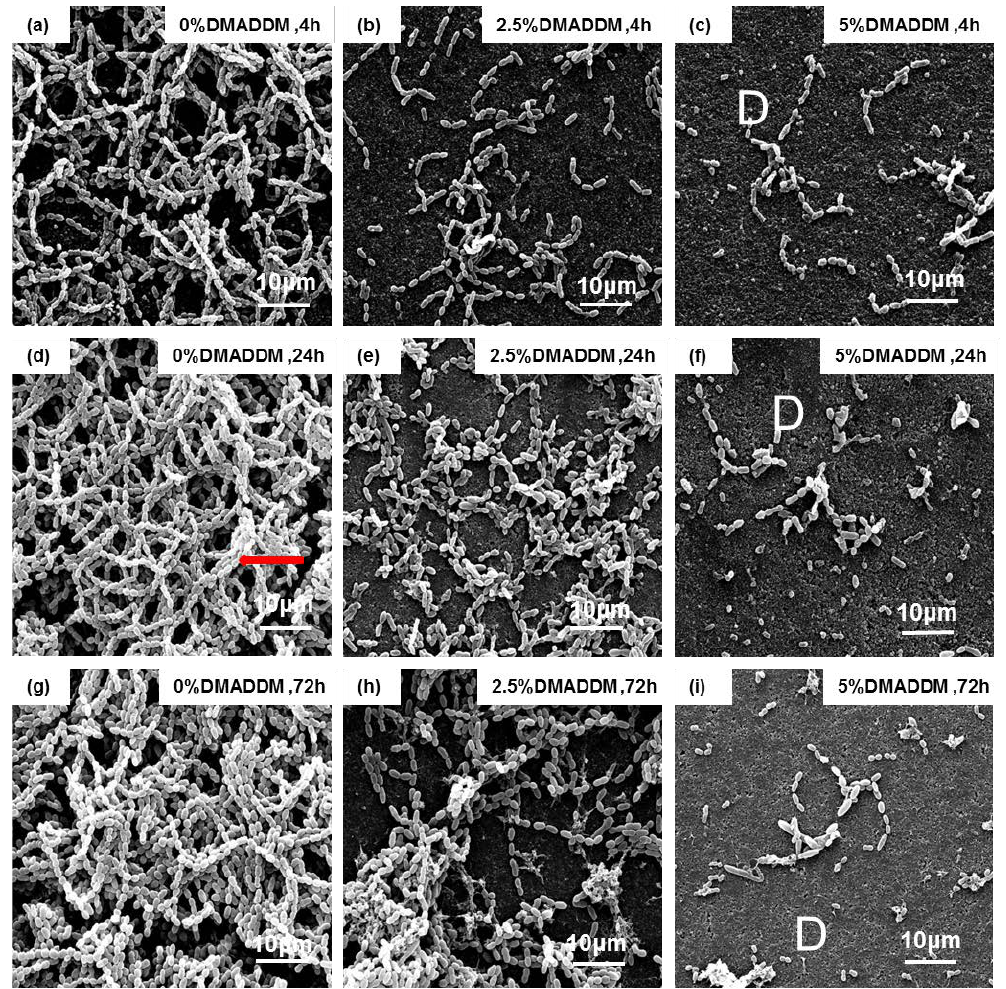
Figure 6. SEM micrographs of typical biofilms in different groups. Each group name is indicated in the image. Adhesives containing DMADDM could reduce the biofilm growing on the disks. Higher mass fraction of DMADDM could have higher anti-biofilm effect. ( a ) 0% DMADDM group, 4 h; ( b ) 2.5% DMADDM group, 4 h; ( c ) 5% DMADDM group, 4 h; ( d ) 0% DMADDM group, 24 h; ( e ) 2.5% DMADDM group, 24 h; ( f ) 5% DMADDM group, 24 h; ( g ) 0% DMADDM group, 72 h; ( h ) 2.5% DMADDM group, 72 h; ( i ) 5% DMADDM group, 72 h; “ D ”, disk surface without biofilms; the red line indicates S. mutans in chains; Scale bar = 10